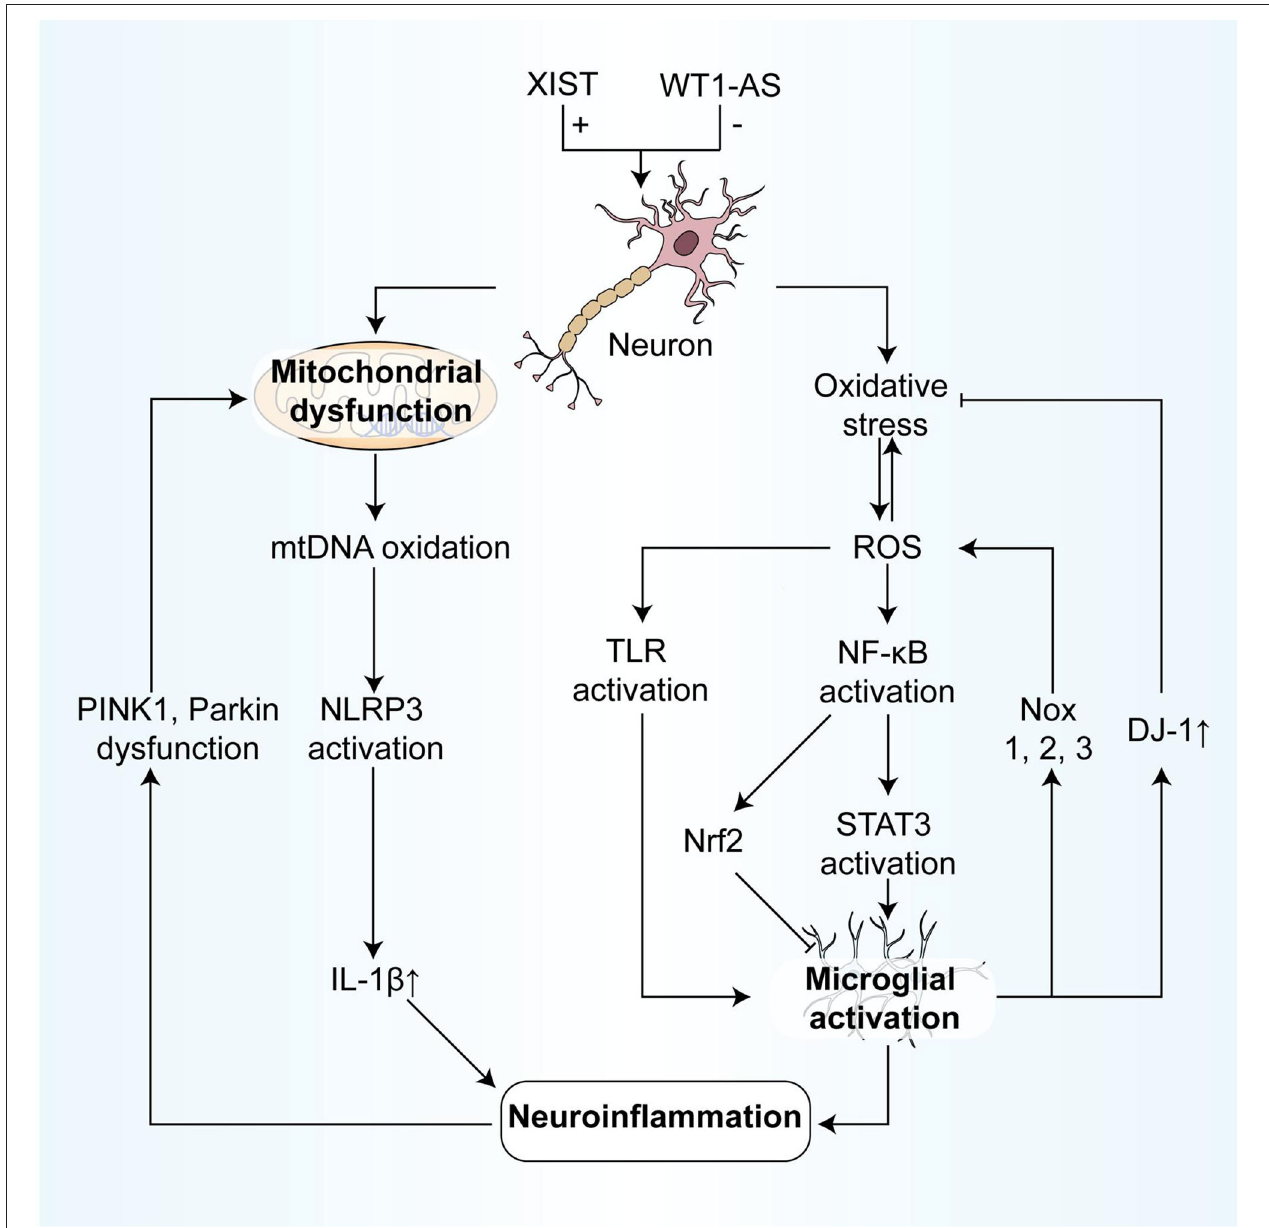
FIGURE 3 | NcRNAs participate in the association between oxidative stress and neuroinflammation, regulating parts of the process. On the one hand, the process from oxidative stress to neuroinflammation includes: (1) ROS modifies and activates TLRs, resulting in the inflammatory response of microglia; (2) ROS degrades I κ B and promotes NF- κ B activation, which in turn activates STAT3, finally leading to microglia activation to participate in neuroinflammation. (3) Also, after NF- κ B is activated by ROS, the activation of Nrf2 can inhibit the microglia activation, resulting in anti-inflammatory effects. (4) Mitochondrial oxidative mtDNA mediates the activation of the NLRP3 inflammasome, resulting in the production of IL-1 β , and in turn, induces neuroinflammation. On the other hand, the effects of neuroinflammation on oxidative stress include: (1) Activated microglial cells can not only produce the large expression of NOX1, 2,3, inducing oxidative stress but also inhibit oxidative stress by expressing large quantities of DJ-1. (2) In neuroinflammation, the dysfunction of PINK 1 and Parkin leads to mitochondrial autophagy blockage, and then results in mitochondrial dysfunction and cell apoptosis. I κ B, IkappaB kinase; NF- κ B, nuclear factor kappa-light-chain-enhancer of activated B cells; Nrf2, Nuclear factor-erythroid factor 2-related factor 2; NOX, NADPH oxidase; PINK 1, PTEN-induced kinase